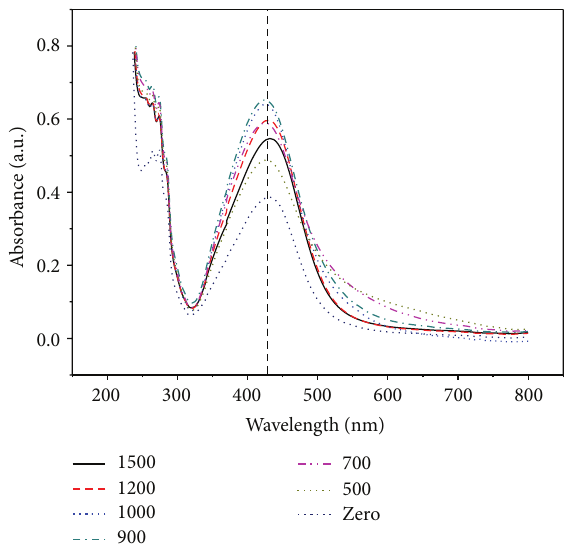
Figure 2: UV-Vis spectrum of PAA (0.1mg) and AgNO 3 (0.5 mL) after addition of AA (10 𝜇 L) and NaBH 4 (10 𝜇 L) with different concentration of sodium citrate (in 𝜇 L).